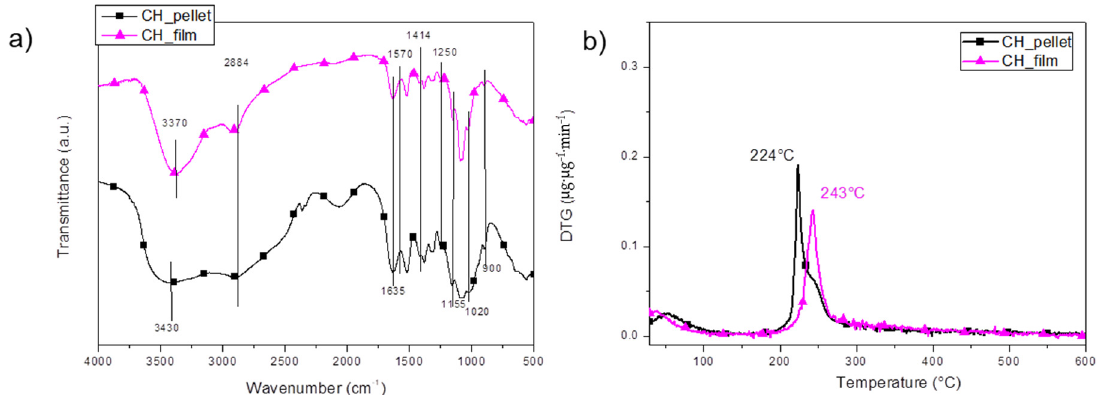
Figure 2. ( a ) FTIR spectra and ( b ) DTG thermograms of the chitosan hydrochloride pellet and